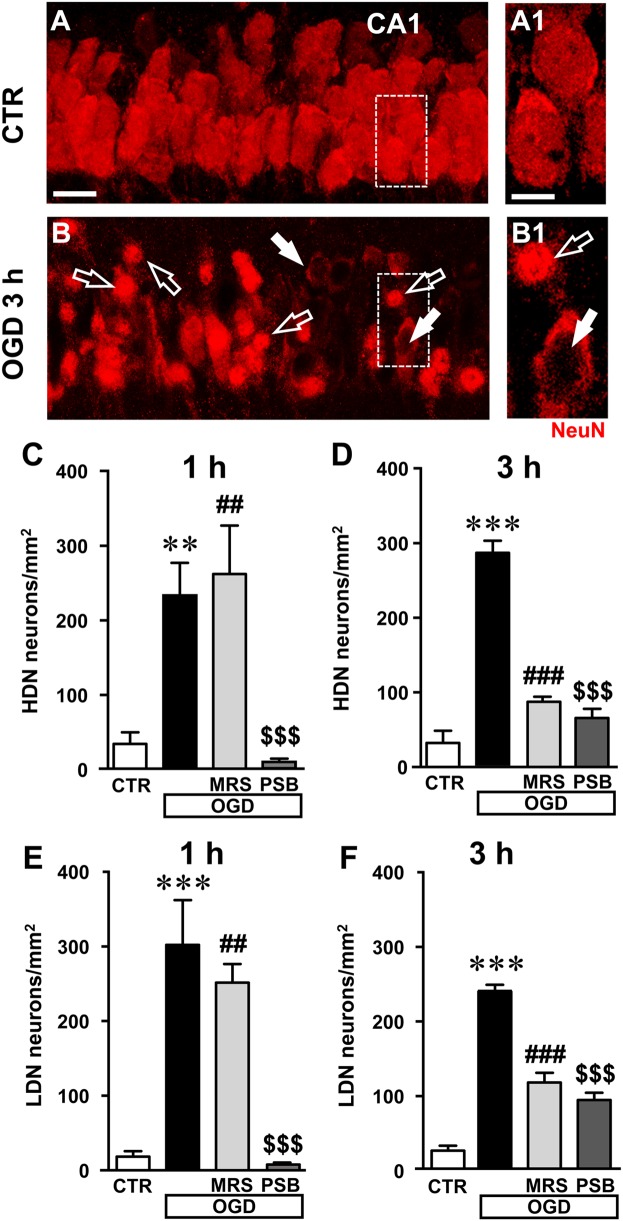
Analysis of damaged neurons in CA1 stratum pyramidale after the simil-ischemic insult. (A–B1) Representative images of NeuN+ immunofluorescence in the CA1 area of a control slice (CTR, A,A1), and of a slice harvested 3 h after the end of 7 min OGD (OGD, B,B1). (A1–B1) magnification of digital subslices of the framed areas in A,B (stacks of two consecutive z-scans taken at 2.1 μm depth inside the neurons, total thickness 0.6 μm). Note the presence of many HDN neurons (open arrows) and LDN neurons (white arrows) in CA1 stratum pyramidale after OGD (B,B1). Scale bars: A,B: 25 μm; A1,B1: 10 μm. (C,D) Quantitative analyses of NeuN+ HDN neurons in CA1 stratum pyramidale 1 h (C) and 3 h (D) after the end of OGD. (C) One-way ANOVA: F(3;12) = 11.32, P < 0.001. Newman–Keuls multiple comparison test: ∗∗P < 0.01, OGD vs. CTR; ##P < 0.01, OGD+MRS vs. CTR;$$$P < 0.001 OGD+PSB vs. OGD. CTR, n = 5; OGD, n = 5; OGD+PSB, n = 3; OGD+MRS, n = 3. (D) One-way ANOVA: F(3;12) = 64.33, P < 0.001. Newman–Keuls multiple comparison test: ∗∗∗P < 0.001, OGD vs. CTR; ###P < 0.001, OGD+MRS vs. OGD;$$$P < 0.001 OGD+PSB vs. OGD. CTR, n = 5; OGD, n = 3; OGD+PSB, n = 4; OGD+MRS, n = 4. (E–F): Quantitative analysis of NeuN+ LDN neurons in CA1 stratum pyramidale 1 h (E) and 3 h (F) after the end of OGD. (E) One-way ANOVA: F(3;14) = 13.80, P < 0.001. Newman–Keuls multiple comparison test: ∗∗∗P < 0.01, OGD vs. CTR; ##P < 0.01, OGD+MRS vs. CTR;$$$P < 0.001 OGD+PSB vs. OGD. CTR, n = 6; OGD, n = 6; OGD+PSB, n = 3; OGD+MRS, n = 3. (F) One-way ANOVA: F(3;12) = 69.77, P < 0.001. Newman–Keuls multiple comparison test: ∗∗∗P < 0.001, OGD vs. CTR; ###P < 0.001, OGD+MRS vs. OGD;$$$P < 0.001 OGD+PSB vs. OGD. CTR, n = 5; OGD, n = 3; OGD+PSB, n = 4; OGD+MRS, n = 4. All data in the graphs are expressed as mean ± SEM.